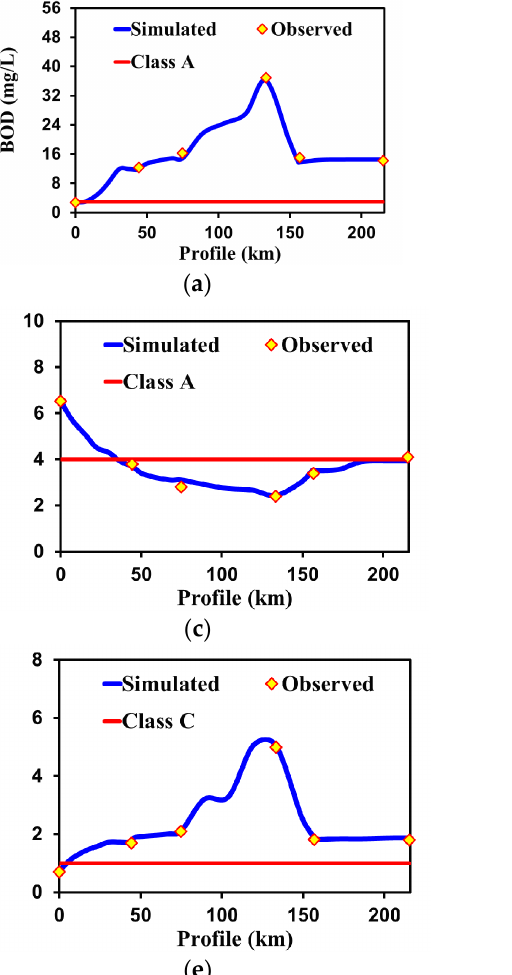
Figure 5. Model calibration of water qualities along the Ravi River for data on 17–18 April 2018: ( a ) BOD, ( b ) TDS, ( c ) DO, ( d ) NO 3 ‐ N, ( e ) NH 3 ‐ N, and ( f ) temperature.